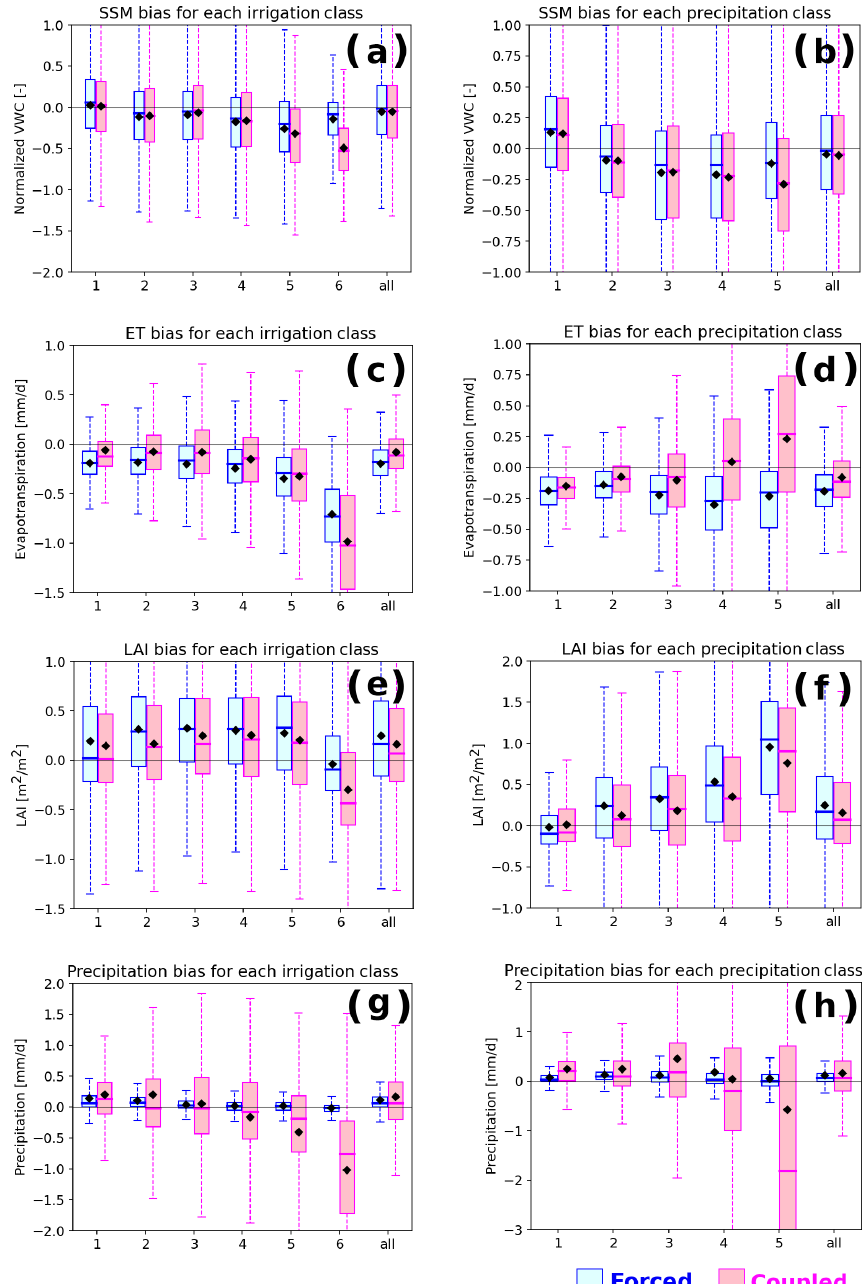
Figure 6. Box plots of mean biases (simulated minus observed values) of SSM, ET, LAI (forced/coupled), and precipitation (coupled only) against each class of irrigation and precipitation. The upper limit, middle line, and lower limit of the boxes correspond to 25, 50, and 75 percentile values, respectively. The upper and lower limits of whiskers are maximum and minimum values, respectively. The diamond indicates the mean value of the class. (a, b) SSM bias. (c, d) ET bias. (e, f) LAI bias. (g, h) Precipitation bias vs. irrigation and precipitation classes, respectively. Blue and pink boxes correspond to forced mode and coupled mode, respectively. The horizontal black line shows zero. Each class of landscape factors (i.e., x axis) is defined in Table